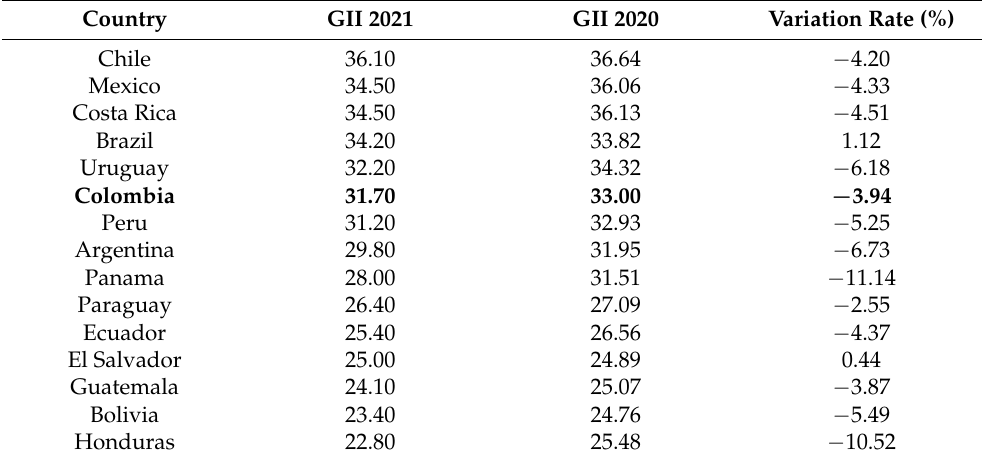
Table 1. GII indices for Latin American and Caribbean countries in 2021 and 2020 (ordered by GII of 2021) and annual variation rates for 2021 with respect to